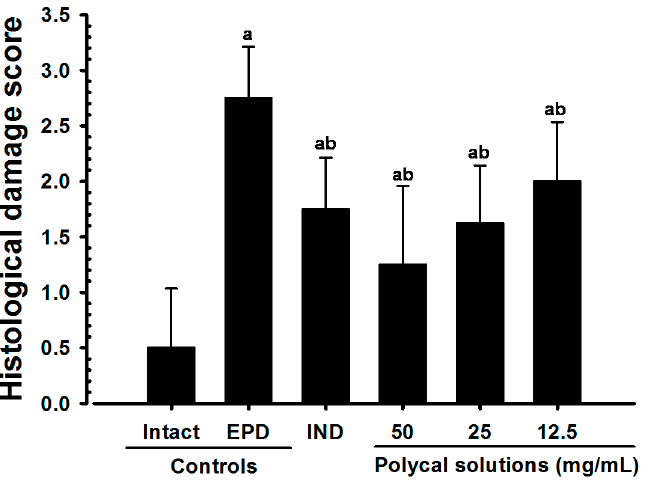
Figure 11. Histological scores in Intact or EPD rats. Values are expressed mean ± S.D. of eight rats, score (Max = 3). EPD = experimental periodontal diseases induced by ligature placement around the cervix of upper left incisor teeth; Polycal = Polycan and calcium gluconate 2:98 (g/g) mixture, which was topically applied to ligated gingival regions, once a day for 10 days (200 μ L/rats); IND = Indomethacin, which was orally administered at 5 mg/kg dose level, once a day for 10 days. a p < 0.01 as compared with Intact control; b p < 0.01 as compared with EPD control.